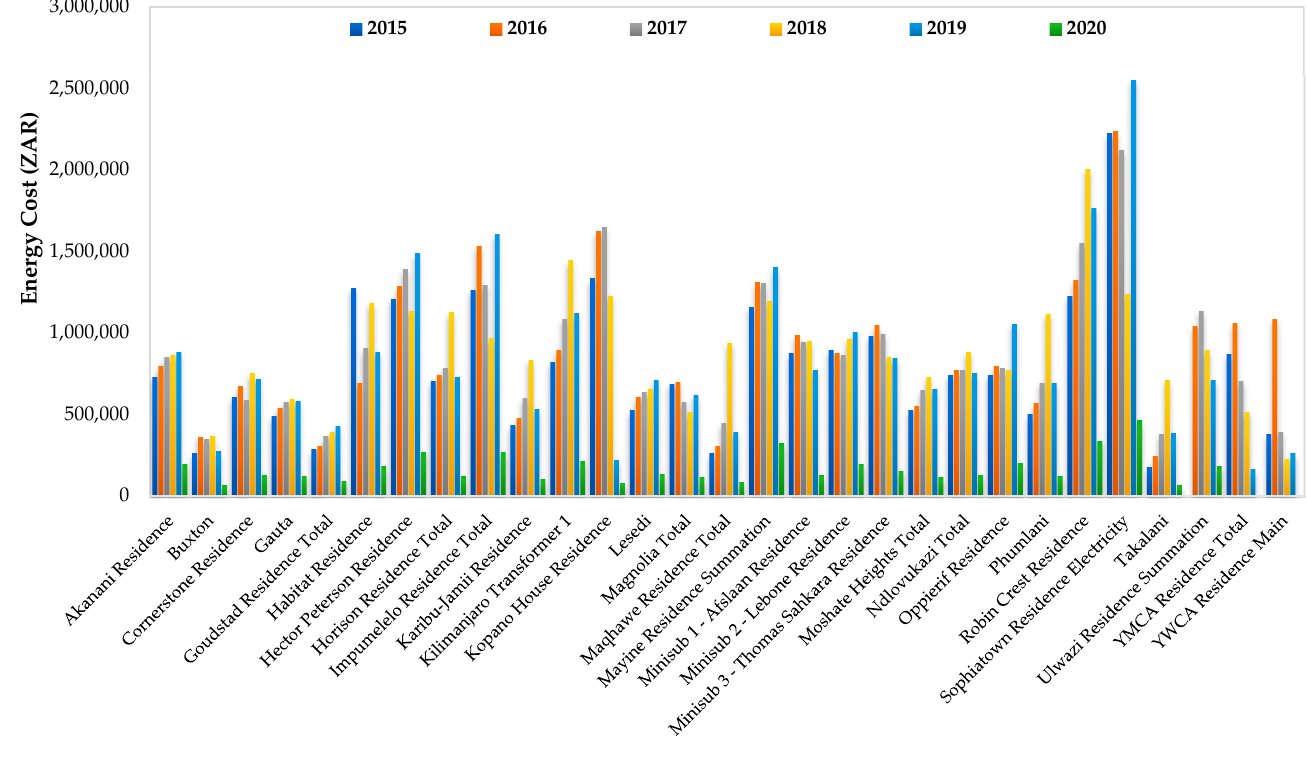
Figure 4. Annual energy cost by each UJ-Res from 2015 to 2020.